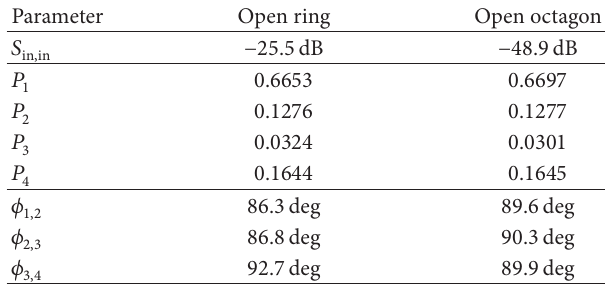
Table 1: Nonuniform series divider design results.